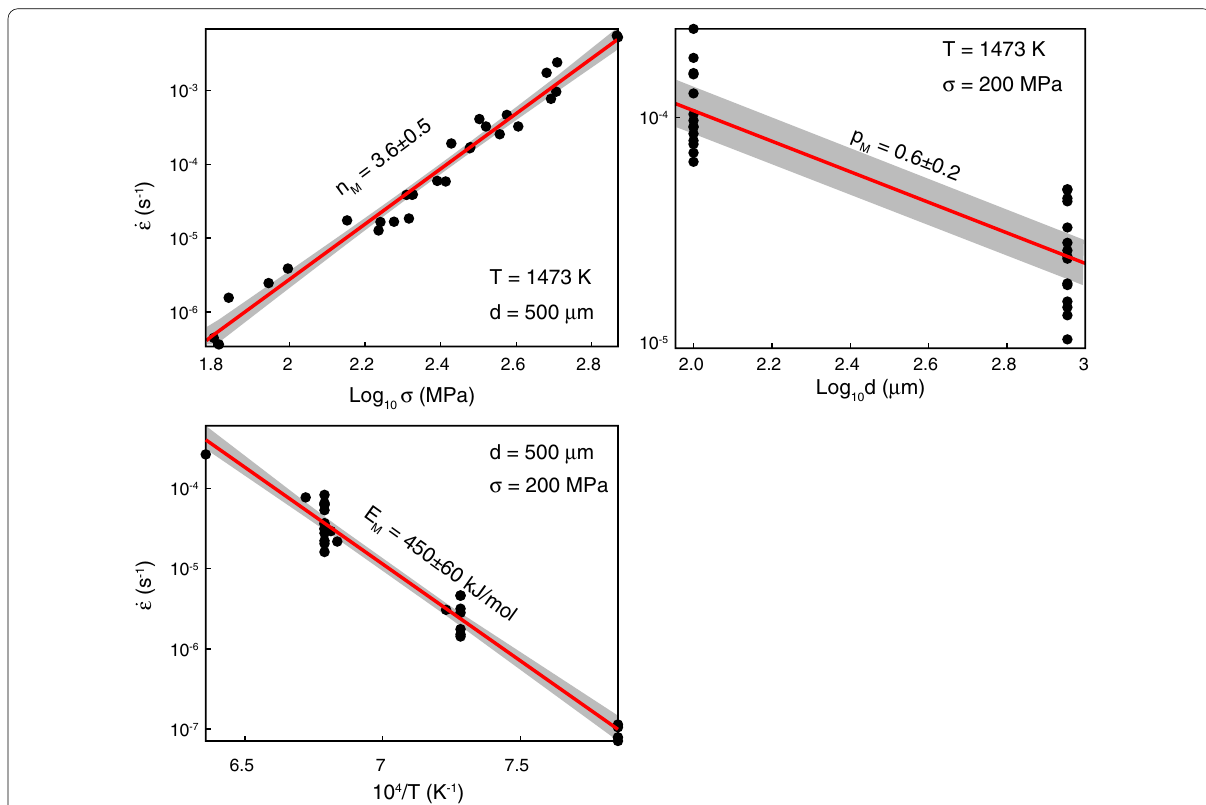
Fig. 6 Least-squares results for the steady-state creep of dunites under hydrous conditions. The best fit model is shown in red and confidence interval in grey. The results are summarised in Table 5. We use the steady state data at various temperatures and strain rates from Table-II and Table-III of Chopra and Paterson (1981). We use all the data except the experimental run, where the steady state was not